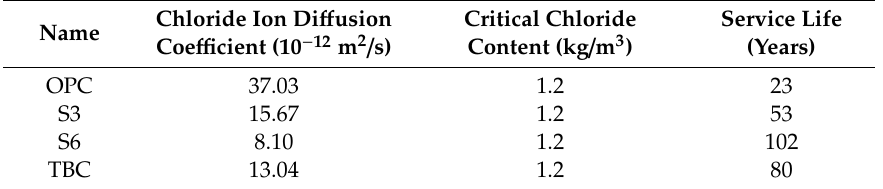
Table 9. The service life of the RC structure by binder type with Korean standard critical chloride content.